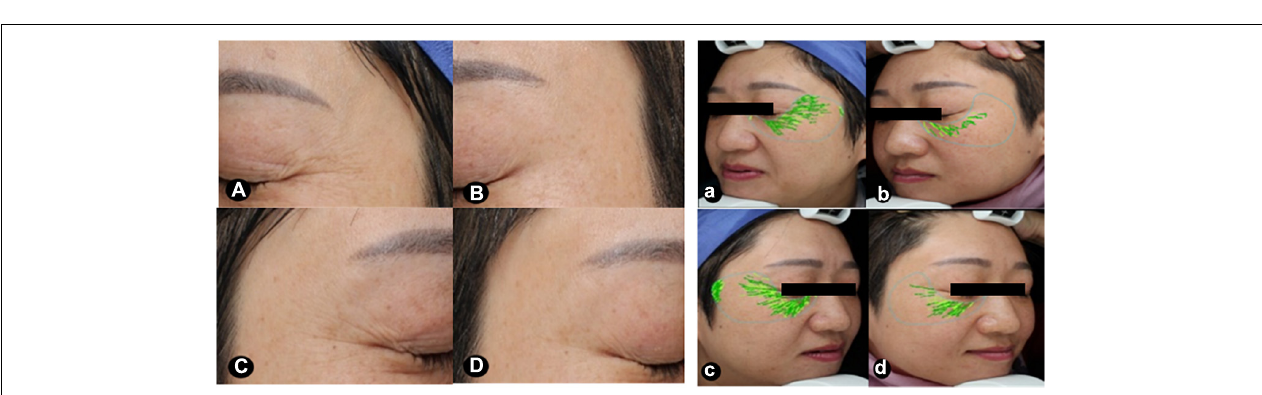
FIGURE 2 | Images focusing on the periorbital areas at baseline and after treatment. The periorbital wrinkles exhibited greater improvements after MN plus hUC-MSCs-CM [ (A,a) baseline; (B,b) after treatment], compared to MN alone [ (C,c) , baseline; (D,d) after treatment]. VISIA R (cid:13) skin analysis assessment for periorbital wrinkles: a = 29.53, b = 8.39, c = 32.37, d = 15.63. MN: microneedling; hUC-MSCs-CM: human umbilical cord-derived mesenchymal stem cells conditioned